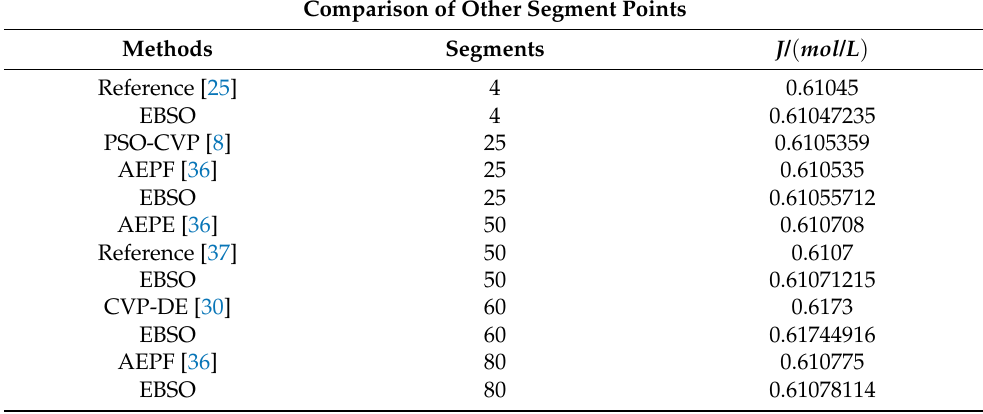
Table 7. Comparison of methods of batch